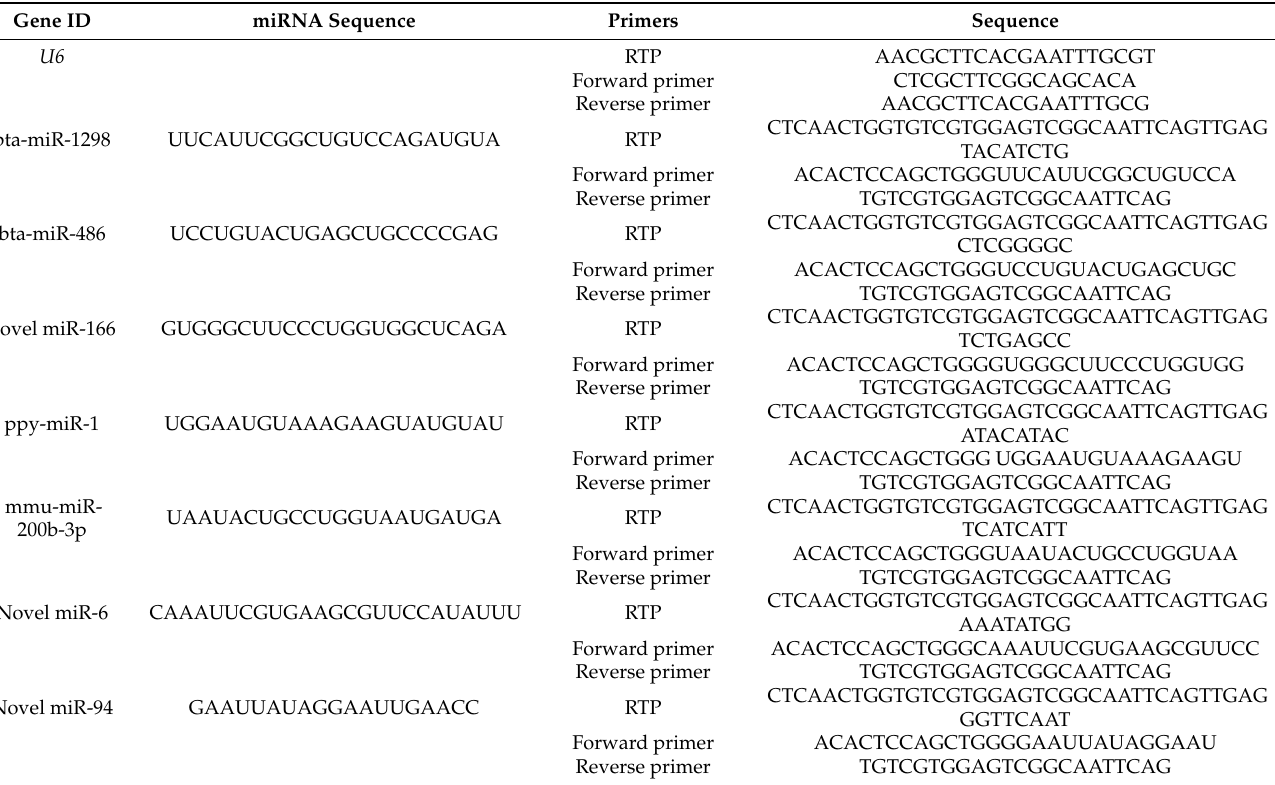
relative expression results were calculated and analyzed via the 2 − Table 1. Primers used for reverse transcription and stem-loop real-time